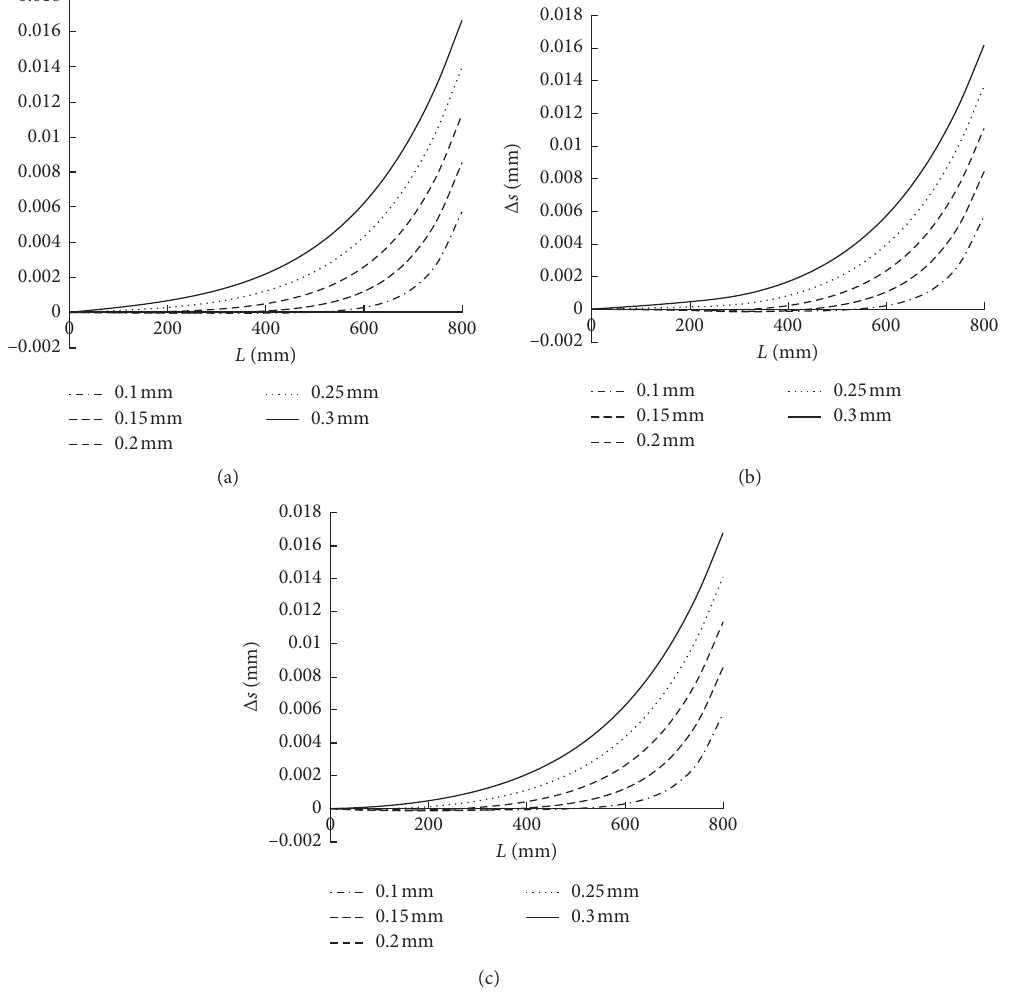
Figure 9: The effect of CFRP sheet’s thickness on the interface slip. (a) Uniform load. (b) Symmetrical concentrated load. (c) Midspan concentrated